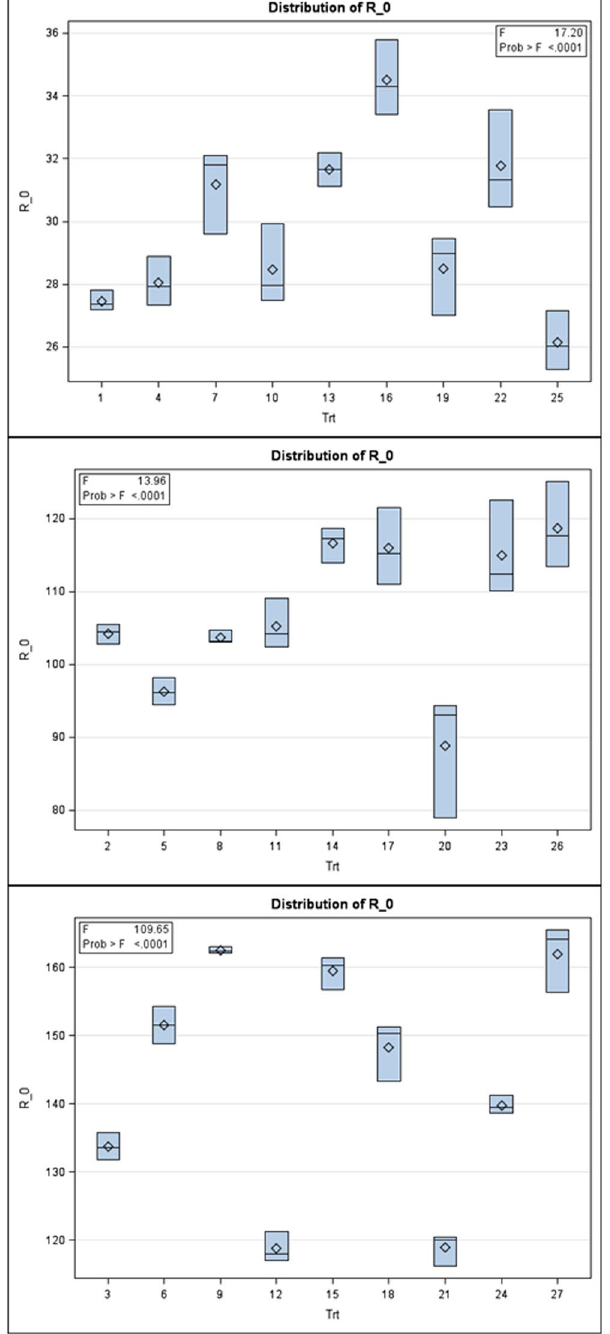
Figure 4. Univariate Box plot results following multivariate MANOVA for the fitness trait r m (labeled as R_m in the figures) over the 3 levels of the N factor. Note the subtle pattern for the group means (in sets of 3 moving by eye from left to right) in each panel and among